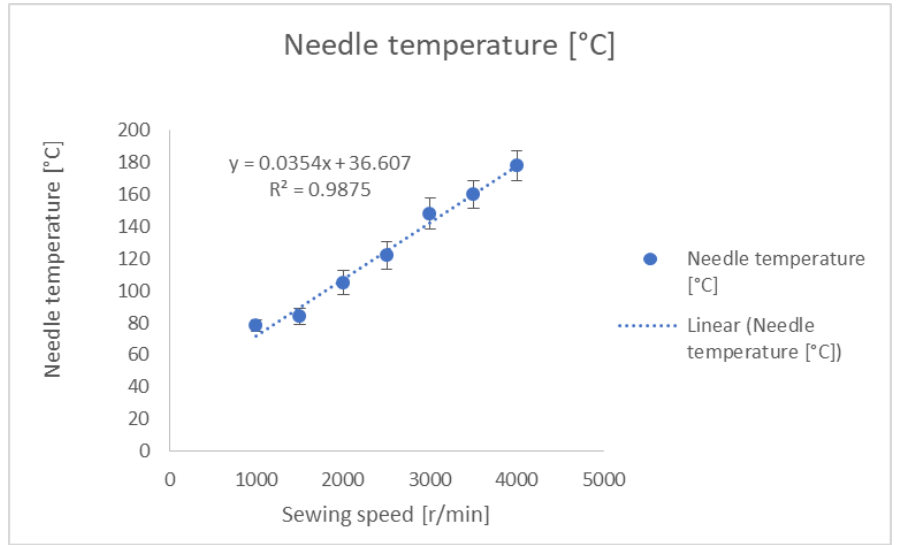
Figure 3. Sewing needle temperature at different sewing speeds .